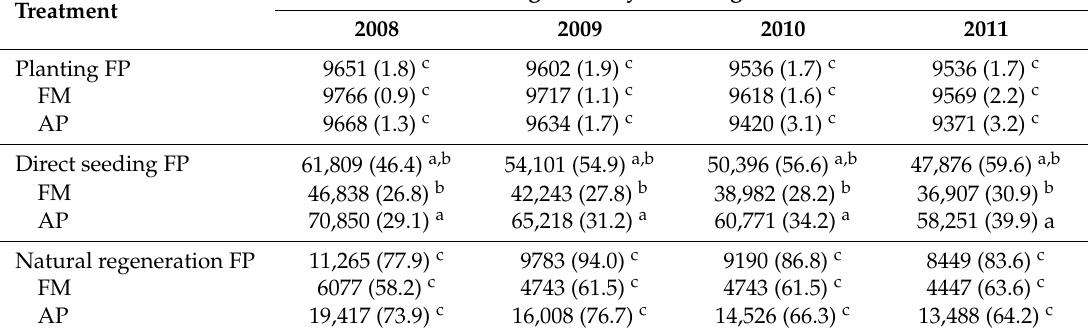
Different letters indicate significant differences in the Tukey HSD test, p ≤